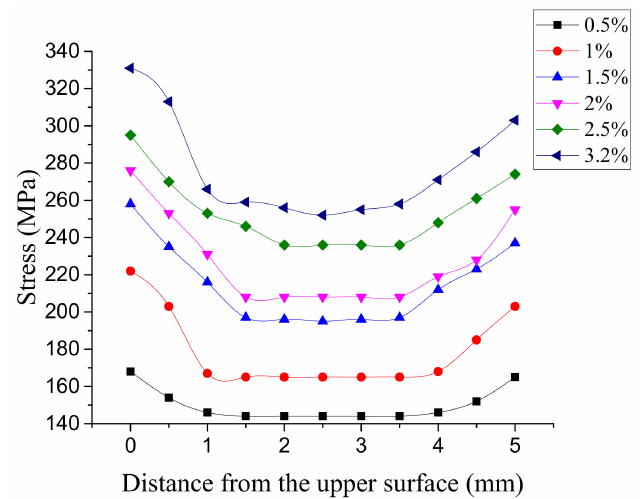
Figure 14. Stress distribution of the hole wall with different interference fit